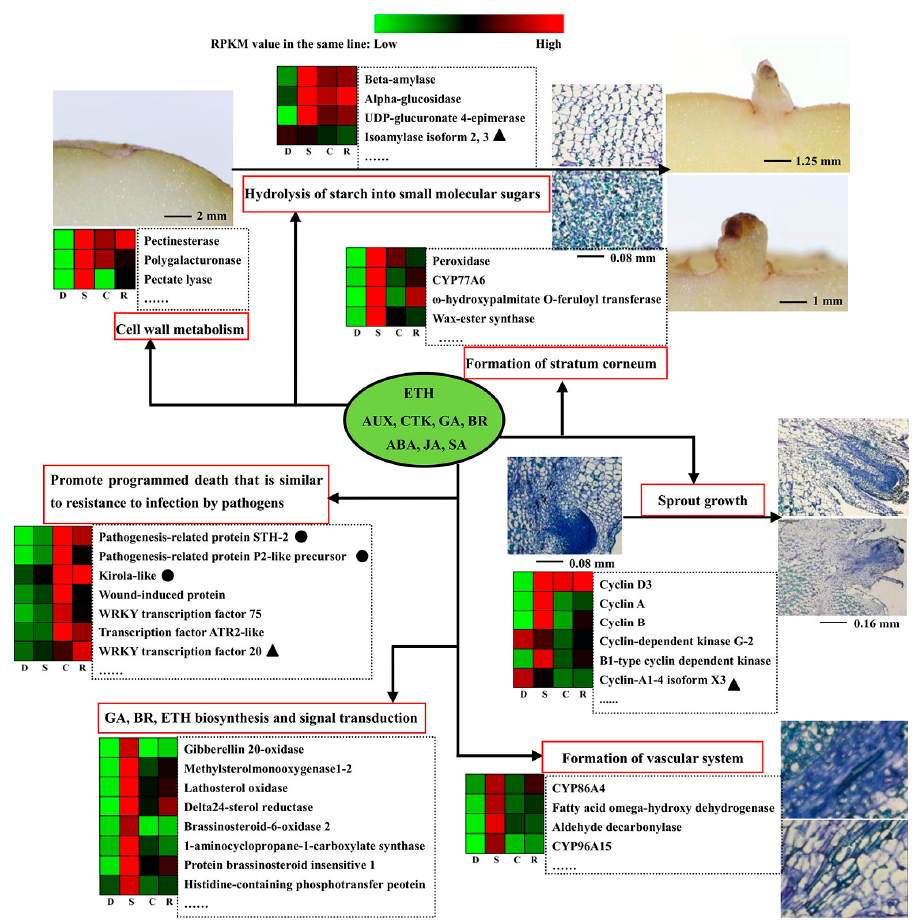
Figure 9. The major genes and proteins involved in tuber dormancy, sprouting and the camphor inhibition. Protein with circle exhibited the same tread at transcriptional and translational levels and the heatmap production using transcription RPKM (Reads per Kb per million reads) values; Protein with triangle meant that changes occurred in translational level; Protein without any symbol meant that changes occurred in transcriptional level.